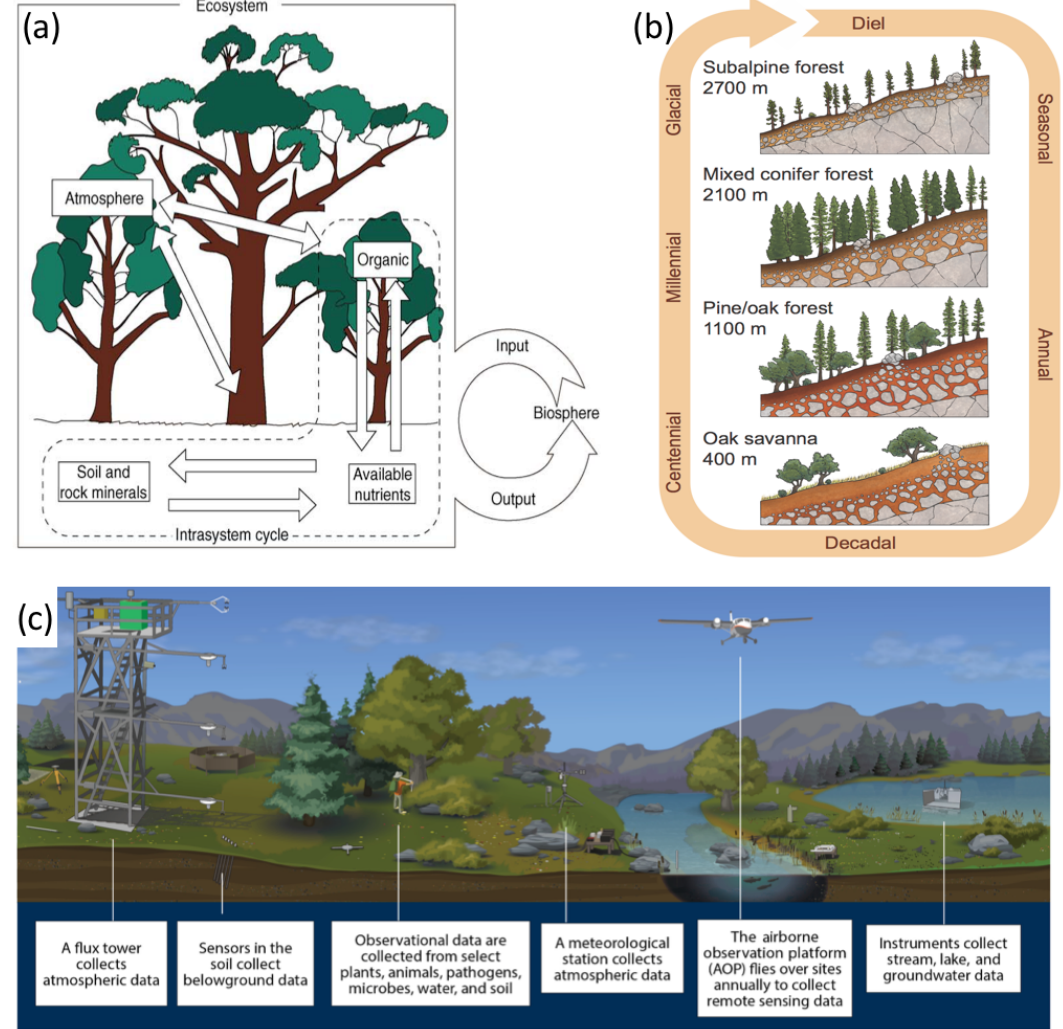
Figure 3. Core conceptual models of (a) ecologists’ ecosystem (Lindenmayer and Likens 2009, after Bormann and Likens 1967), (b) Earth scientists’ critical zone (courtesy of the Southern Sierras Critical Zone Observatory), and (c) an EON design (courtesy of the USA’s National Ecological Observatory Network) that includes an eddy covariance flux tower that is the basis for the FLUXNET program. The congruence of the ecosystem and critical zone concepts that guide these networks motivates biogeoscientists to consider how to get the most from these long-term research